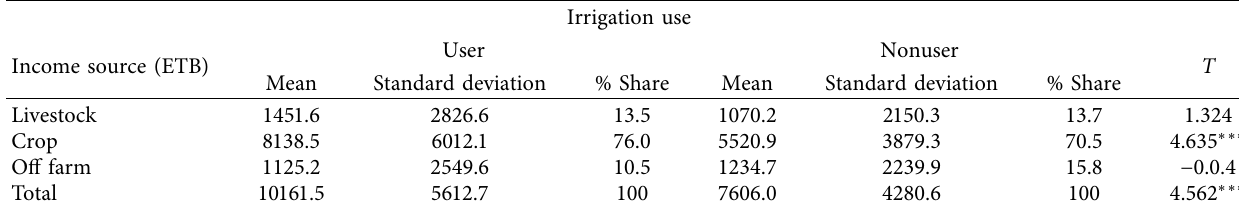
Table 6: Income earned by households with and without